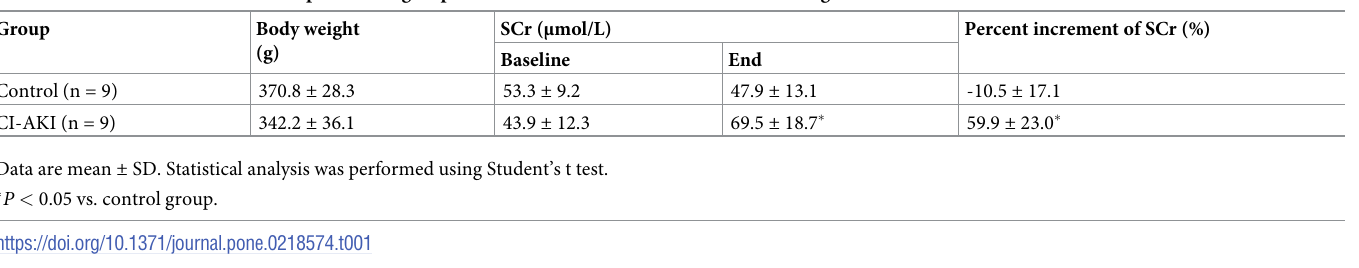
Table 1. Baseline characteristics of experimental groups and the effects of contrast medium on changes in SCr elevation.